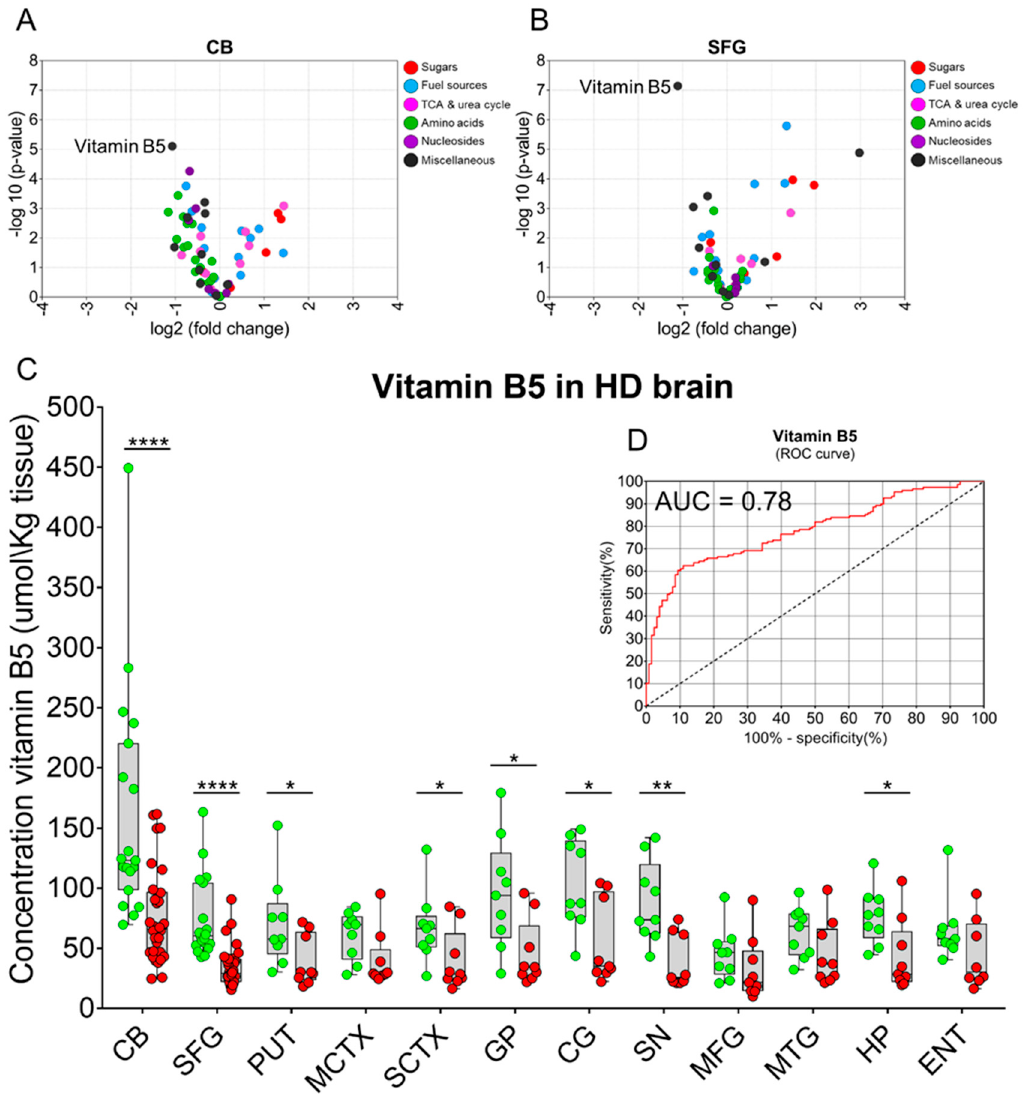
Figure 4. Evidence that vitamin B5 levels are decreased in multiple brain regions in HD. ( A , B ) Volcano plots showing individual metabolites and metabolite-groups dysregulated in HD brains in CB and SFG respectively. Vitamin B5 (D-pantothenic acid) was the most significantly altered metabolite identified in both brain regions. ( C ) Distributions of individual vitamin B5 concentrations ( µ mol / kg tissue) overlaying aggregated data (boxplots) in each of 12 brain regions of controls (green circles) and HD cases (red circles). Vitamin B5 concentrations are significantly reduced in CB, SFG, PUT, SCTX, GP, CG, SN, and HP (two-tailed t -tests for each region). ( D ) Receiver operating characteristic (ROC) curve for stratification of HD, based on vitamin B5 measurements was calculated using vitamin B5 concentrations extrapolated from a reference calibration curve ( n = 278 brain samples). The AUC value was 0.78 with p < 0.0001. Here, the study group comprised all HD cases ( n = 31, grades 0–4; red circles), and controls ( n = 24; green circles); boxplots are means ± 95% CI. Abbreviations: *, p < 0.05; ** < 0.005, ***, < 0.001; ****, < 0.0001; MCTX, motor cortex; MFG, medial frontal gyrus; MTG, medial temporal gyrus; ENT, entorhinal cortex. Table 2. Vitamin B5 concentration levels in controls and HD cases. Table illustrating the mean (±95% CI) values of vitamin B5 concentration for each brain area analysed in controls and HD gene-carriers. The overall mean of vitamin B5 concentration across all the brain areas is also reported in the table. Concentration values have been expressed as µmol/kg brain tissue. Multiple two-tailed t -tests were